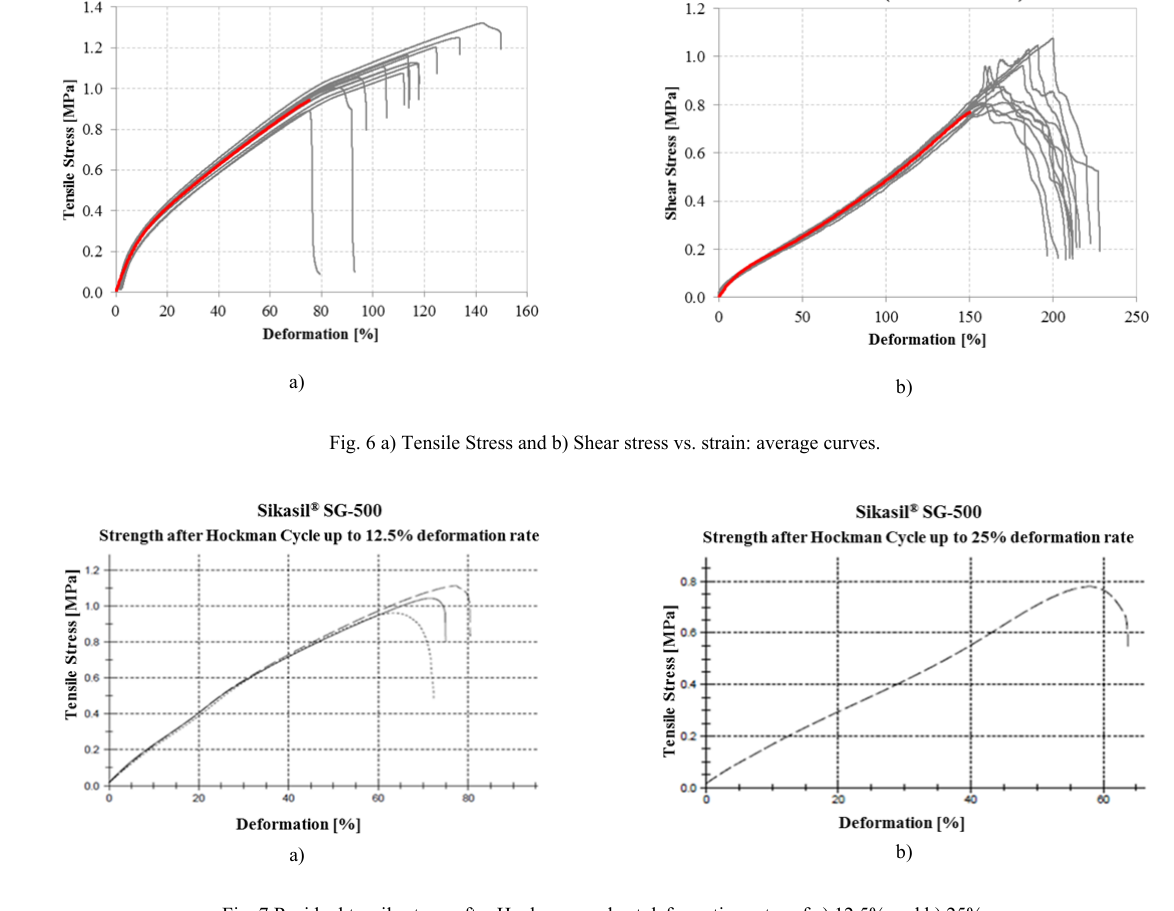
Fig. 7 Residual tensile stress after Hockman cycle at deformation rates of a) 12.5% and b)